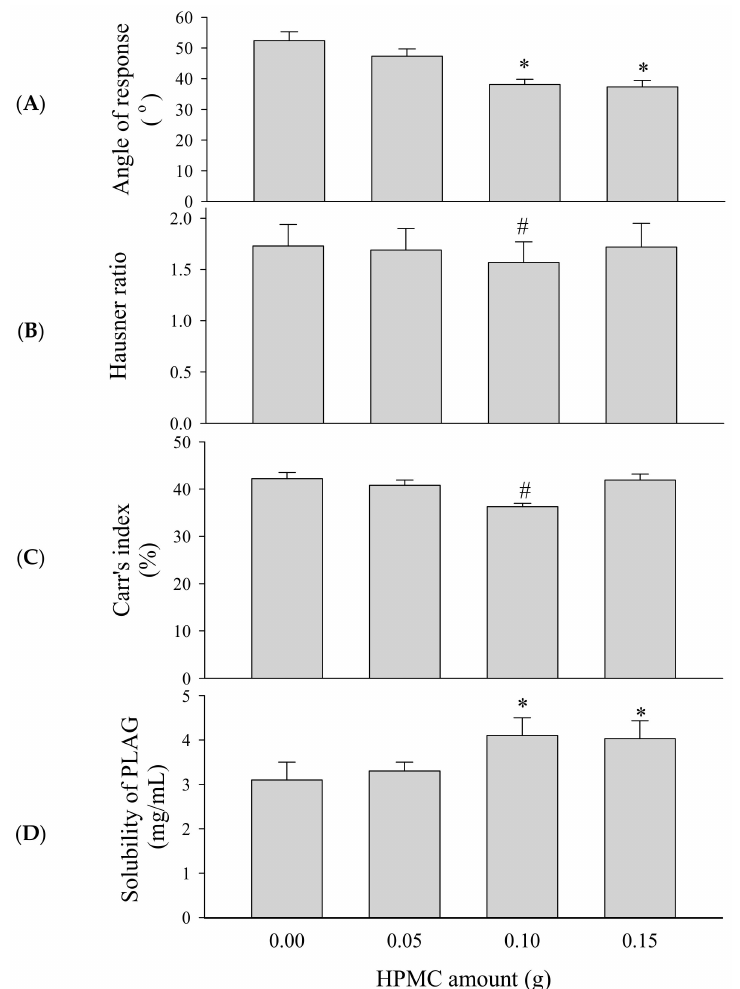
Figure 4. E ff ect of HPMC amounts on the flow ability and solubility of self-emulsifying granule system (SEGS). Each value represents the mean ± SD ( n = 3). * p < 0.05 compared with HPMC amount (0 and 0.05 g); # p < 0.05 compared with HPMC amount (0, 0.05, and 0.15 g). ( A ) Angle of repose; ( B ) Hausner ratio; ( C ) Carr’s index; ( D )